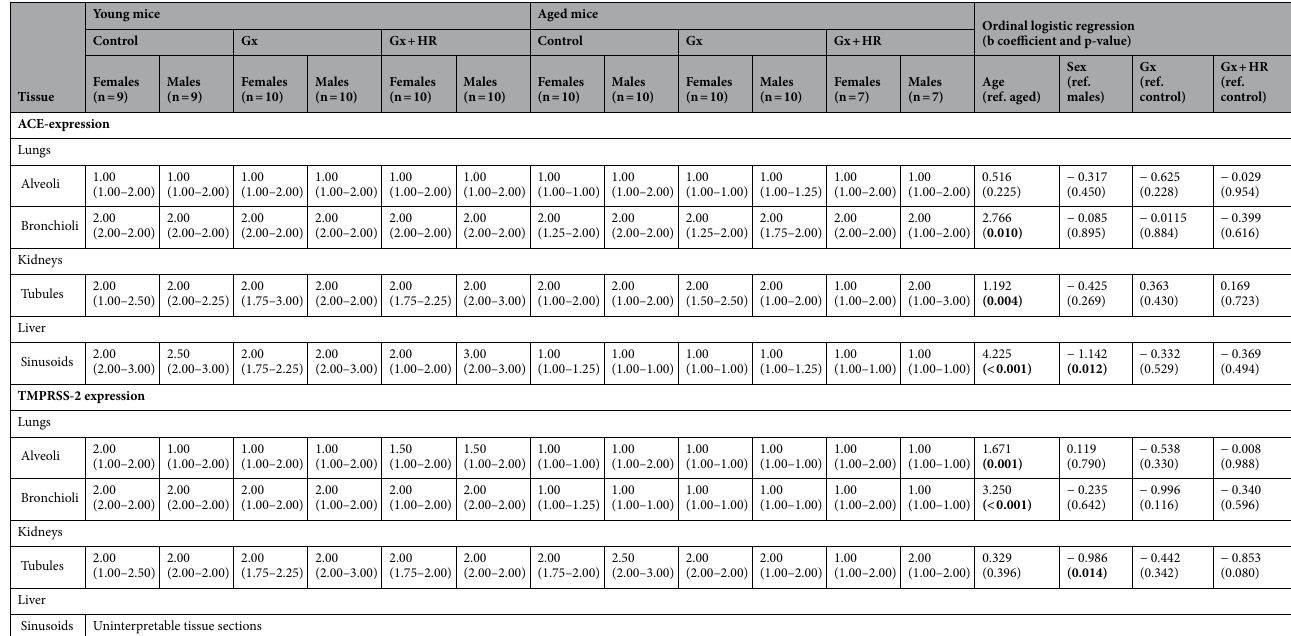
Table 1. Impact of age, sex and hormone deprivation/replacement status on ACE-2 and TMPRSS-2 expression at baseline condition. Data are expressed as median (interquartile range). P-values were derived from ordinal logistic regression. Significant values are in bold. ACE-2, angiotensin-converting enzyme 2; Gx, gonadectomy; HR, hormone replacement; TMPRSS-2, transmembrane protease serine